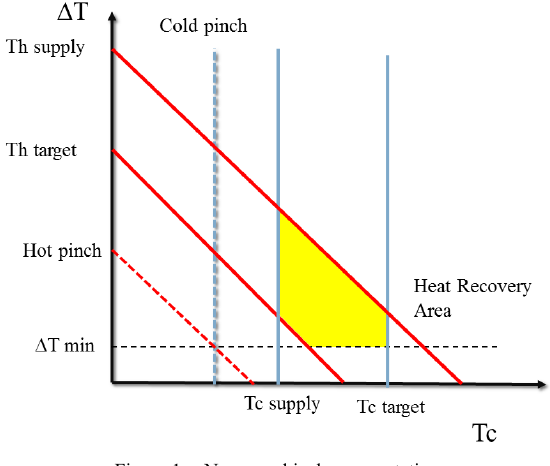
Figure 1. New graphical